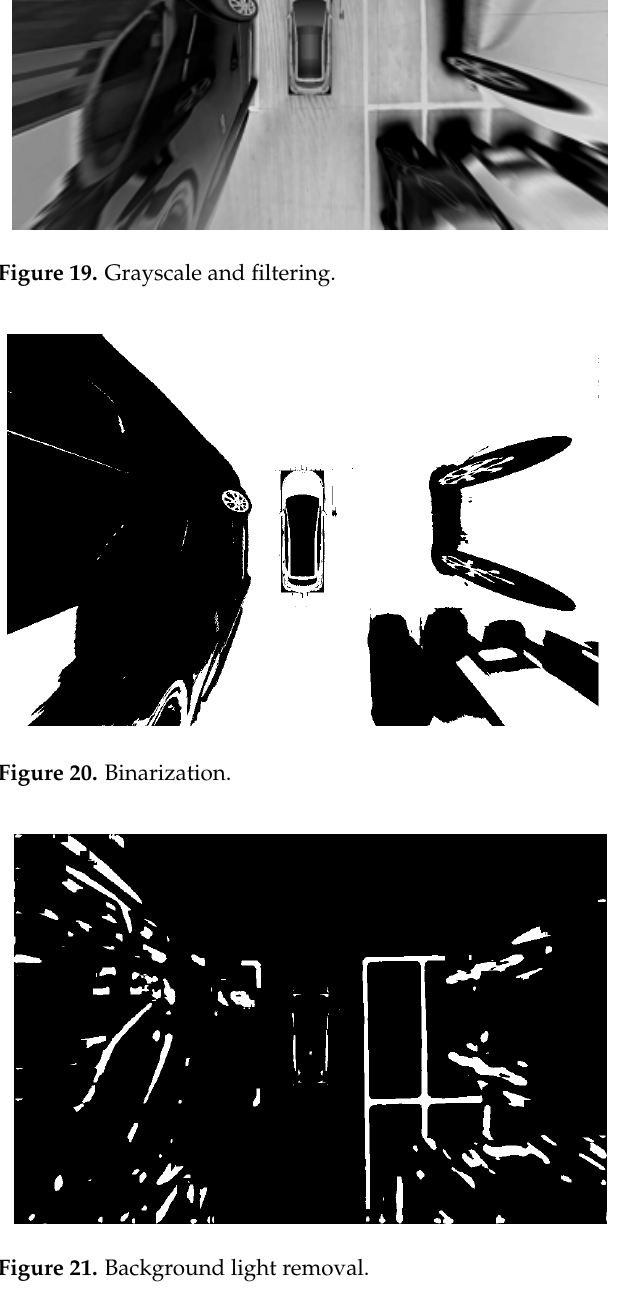
Figure 21. Background light removal.